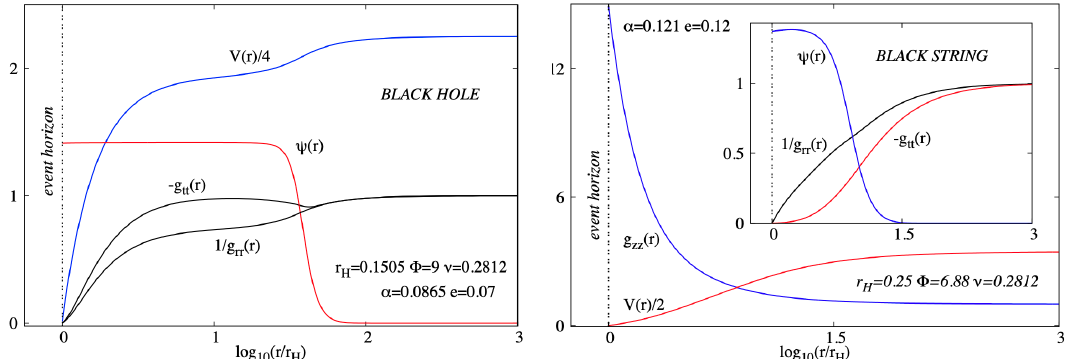
Figure 1 . Profile functions of a typical BH (left) and BS (right) are shown as functions of the radial